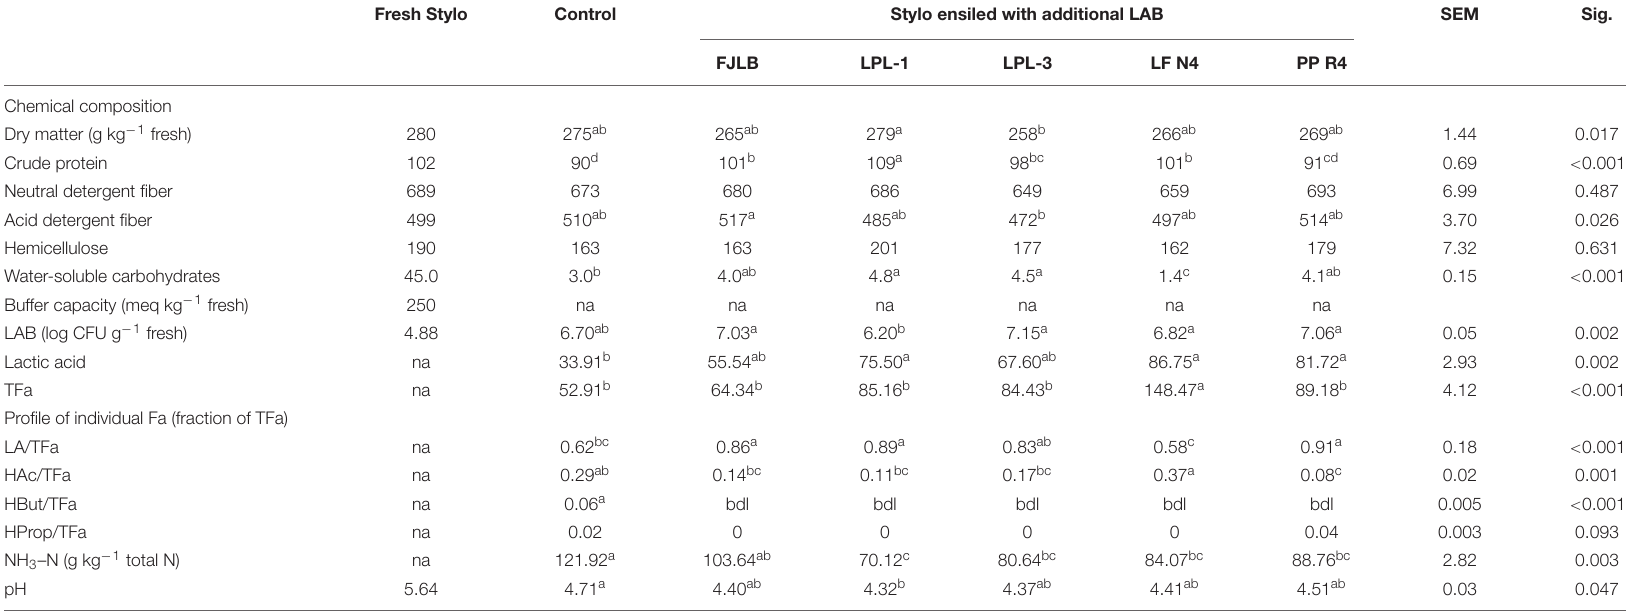
TABLE 2 | Chemical composition of fresh and ensiled Stylo, and selected indices of fermentation after 45 days of ensiling with or without additional LAB. Fresh Stylo Control Stylo ensiled with additional